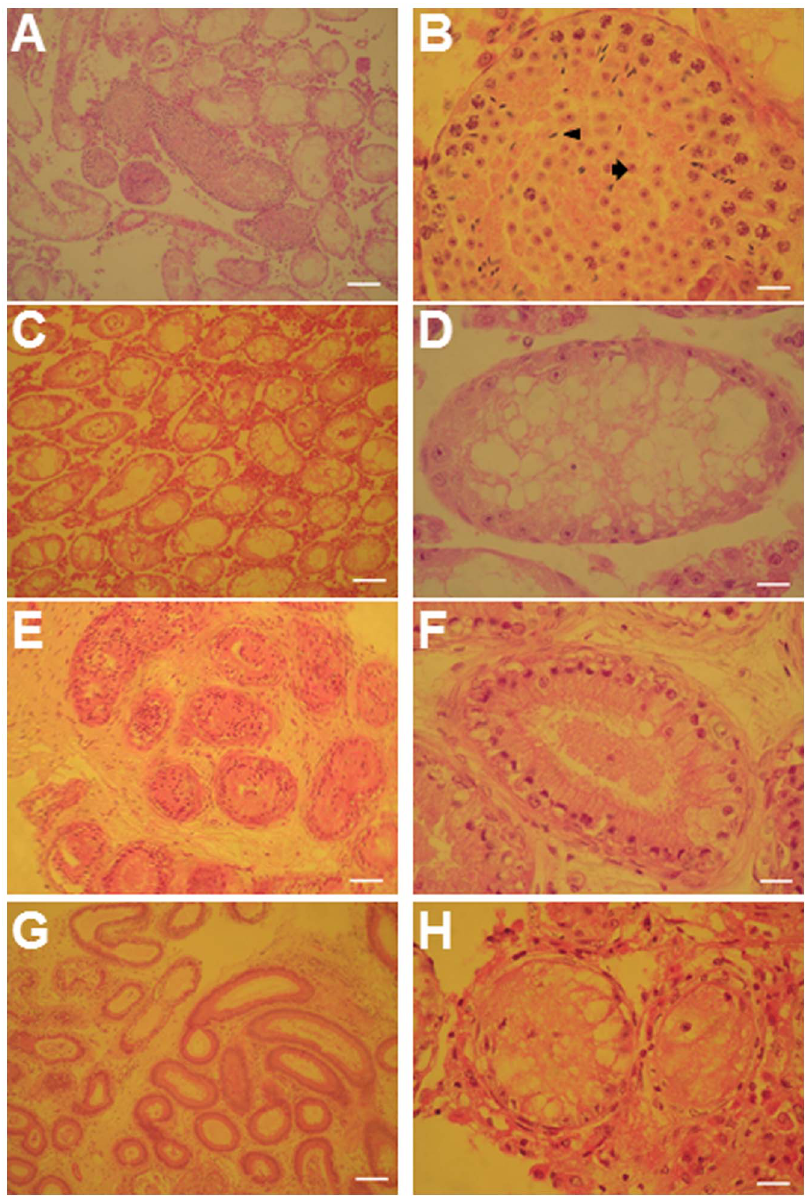
Figure 3. Histological sections of transplanted and non-transplanted GSCs into the testis. ( A–B ) GSCs without Gcnf siRNA (controls, only with tomato lentivirus). Note the presence of pachytene cells, round spermatids, and fully-grown sperm inside the testicular tubules of the right testis. ( C–D ) Non-transplanted testicular tubules of the left testis from the same mice, showing no recovery of germ cells in germ cell–depleted testes 3 months after treatment with busulfan. ( E–F ) GSCs with Gcnf siRNA. Note that GSCs colonized the testicular tubules of the right testis, but failed to differentiate into sperm. ( G–H ) Non-transplanted testicular tubules of the left testis from the same mice, showing no recovery of germ cells in germ cell–depleted testes 3 months after treatment with busulfan. Note that the scale bars in the left panel are 20 uM and in the right panel are 10